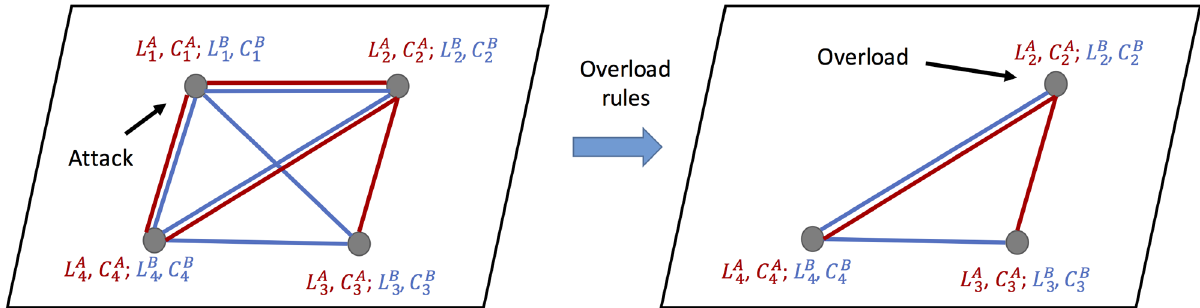
Fig 1. A schematic of our model of overload-based cascading failures on multiplex networks. The system of multiplexnetworks is composedof two layers A and B (red and blue links respectively), which share the same set of nodes. At each time step t (cid:21) 0, each node has ð t Þ and L B ð t Þ , definedas the its betweenness centrality in each layer. Each node also has two fixed capacities,definedas two load values L A i i C